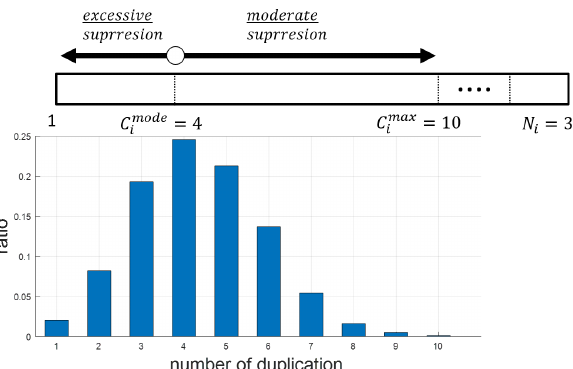
Figure 7. An example of duplication counter